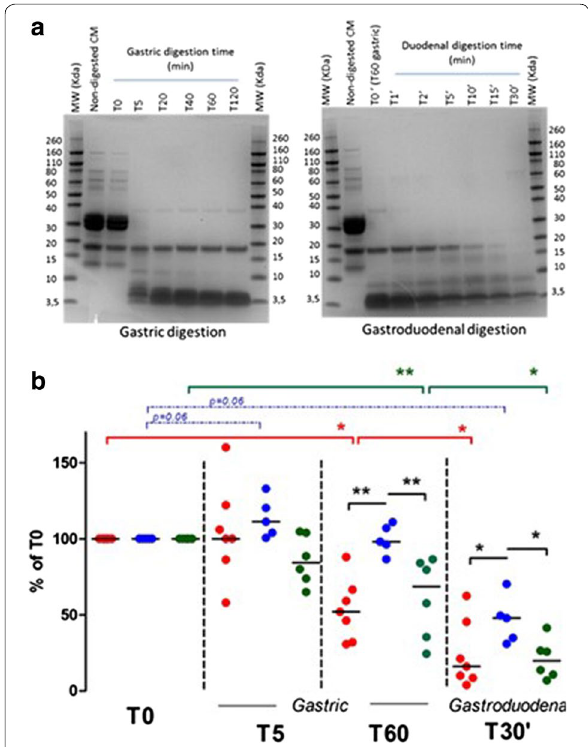
Fig. 4 Specific IgG4 against gastroduodenal digestion products. a Electrophoresis of gastroduodenal CM protein digestion products: CM was digested for 0 to 120 min under physiological conditions using pepsin (T0 to T120, gastric digestion). Digestion products obtained after 60 min of pepsin digestion (T60 gastric, TO’) were then submitted to trypsin/chymotrypsin physiological digestion for 1 to 30 min (T1 ′ to T30 ′ , gastroduodenal digestion). b Undigested CM proteins (T0), gastric digestion products obtained at 5 (T5) and 60 min (T60) and gastroduodenal digestion products obtained after 60 min of gastric digestion and 30 min of duodenal digestion (T30 ′ ) were immobilized on plates, and specific IgG4 were assayed using individual plasma (FPIES‑CMA: red, IgE‑CMA: blue, IgE‑PNA: green). Absorbance obtained at T0 was used as an internal reference for each patient (100%). Statistics: bars and asterisks indicate statistical differences between specified time points and T0 in one group of patients (* p < 0.05, ** p < 0.01; Wilcoxon sign rank test) or significant differences between groups at a given time of digestion (* p < 0.05, ** p < 0.01; Mann–Whitney t